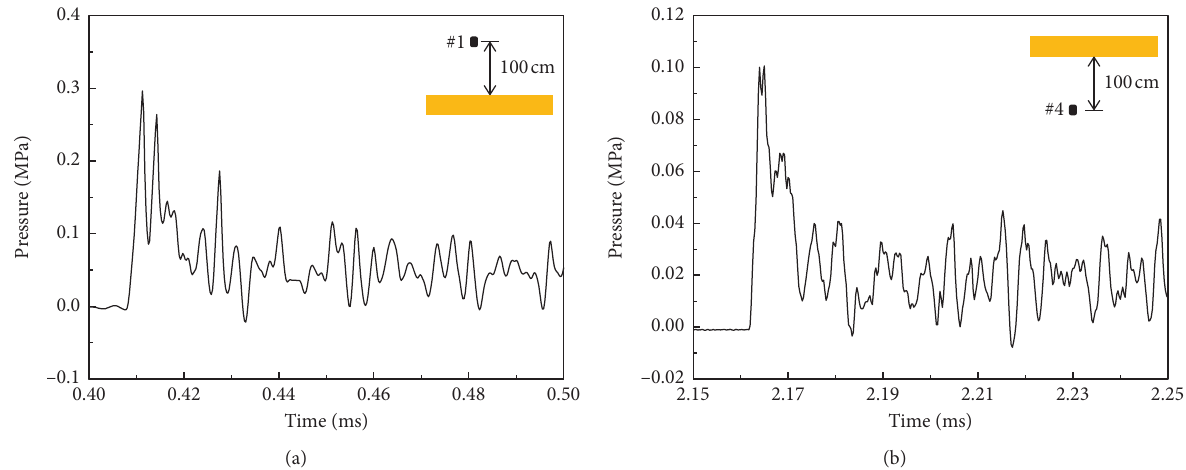
Figure 10: Time history curves of air shock wave pressure of B0. Air shock wave measured using (a) sensor #1 and (b) sensor